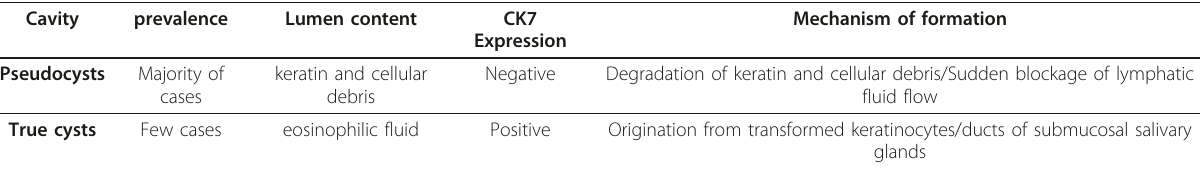
Table 1 Differences between real cysts and pseudocysts in metastatic lymph nodes